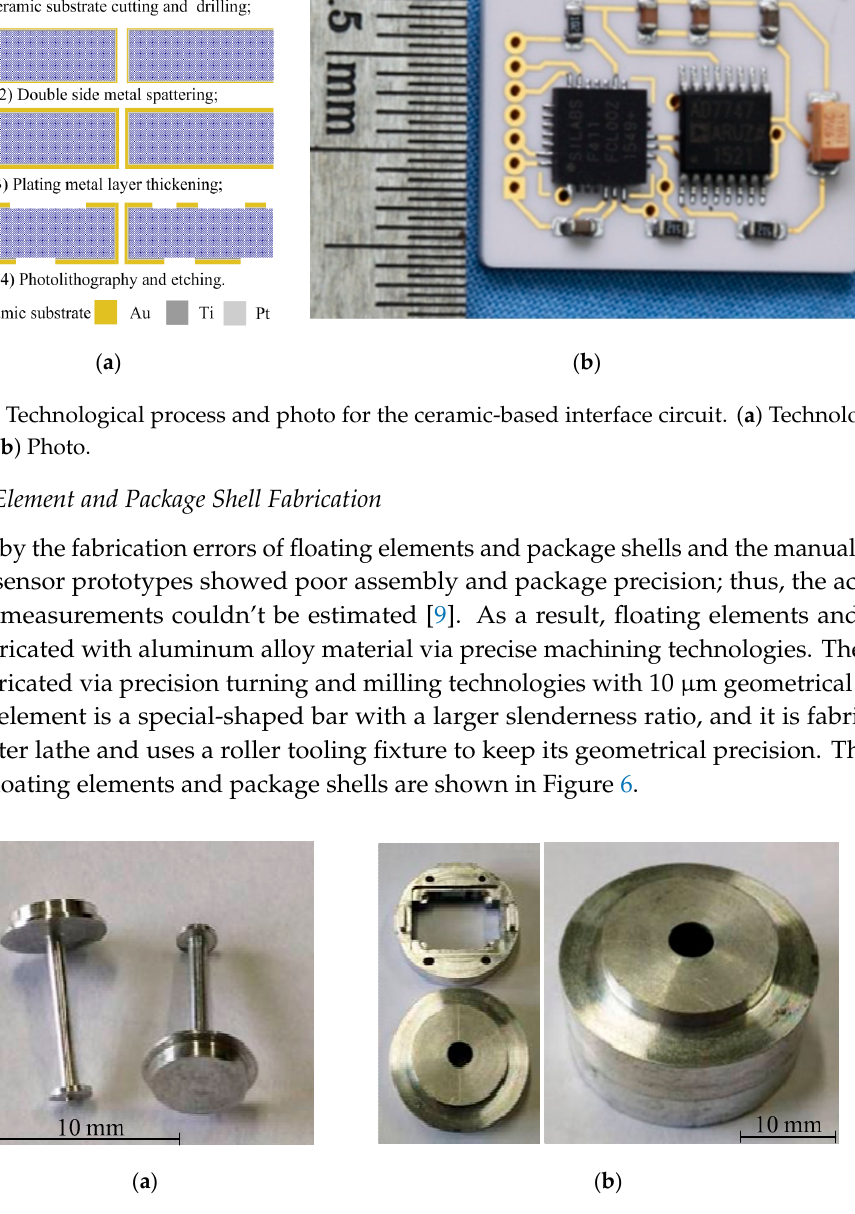
Figure 4. The frontal and rear photos of bonded microstructure.